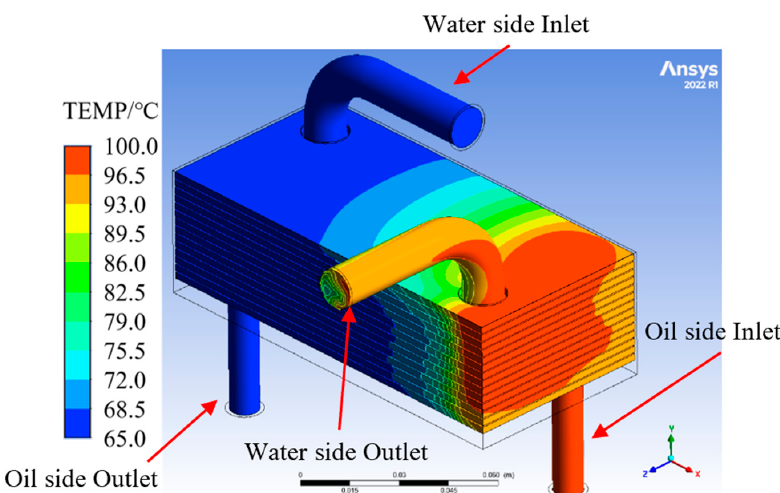
Figure 9. Simulation results of optimal parameters.